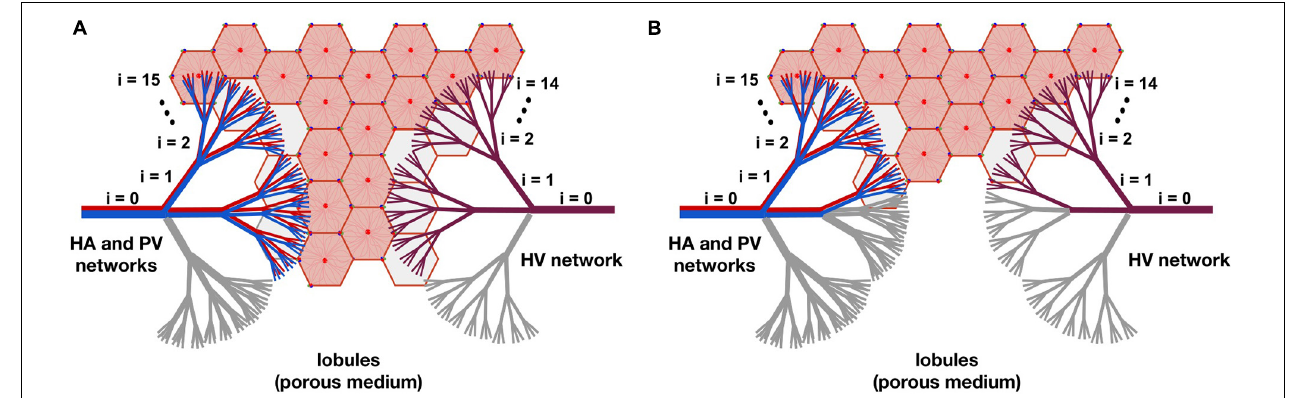
FIGURE 3 | The model of liver resection showing two of the tested resection schemes, 33 and 78% in (A,B) , respectively. In (A) , all vessels belonging to one of the three branches of level i = 1, indicated in gray, are “removed” (by making their cross-sectional areas tend to zero). This means “eliminating” 33% of the smallest vessels -vessels at level i = 15 for the HA and PV networks, and vessels at level i = 14 for the HV network-, so 33% of the lobules are also “removed” (reducing the original amount of them). In (B) , all vessels belonging to one of the three branches of level i = 1 and to two of the six remaining branches of level i = 2, indicated in gray, are “removed.” This means the “elimination” of 78% of the smallest vessels of the networks and therefore of the lobules.